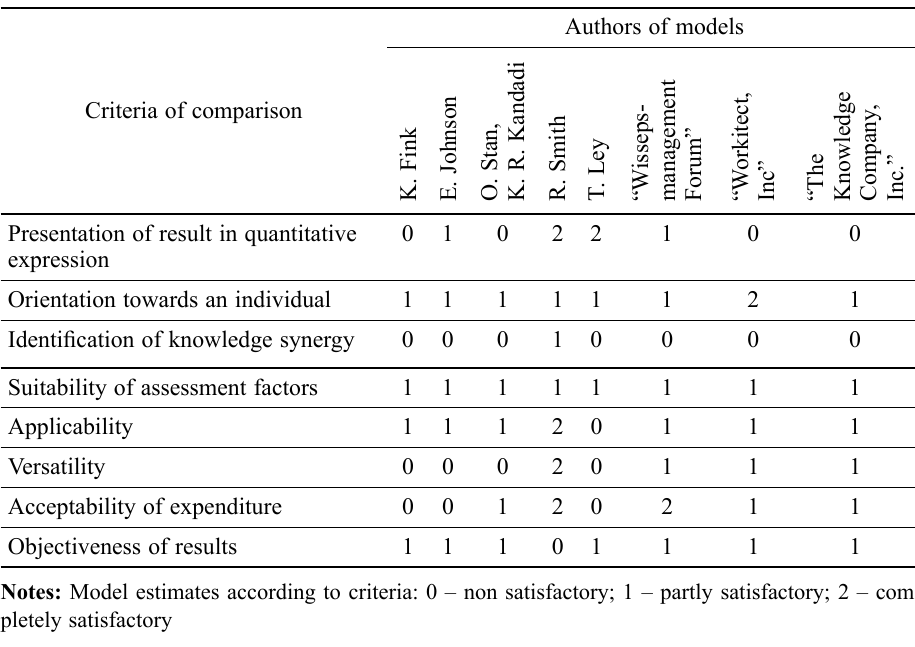
Table 1. Comparison of the models assessing an organizations’ knowledge potential